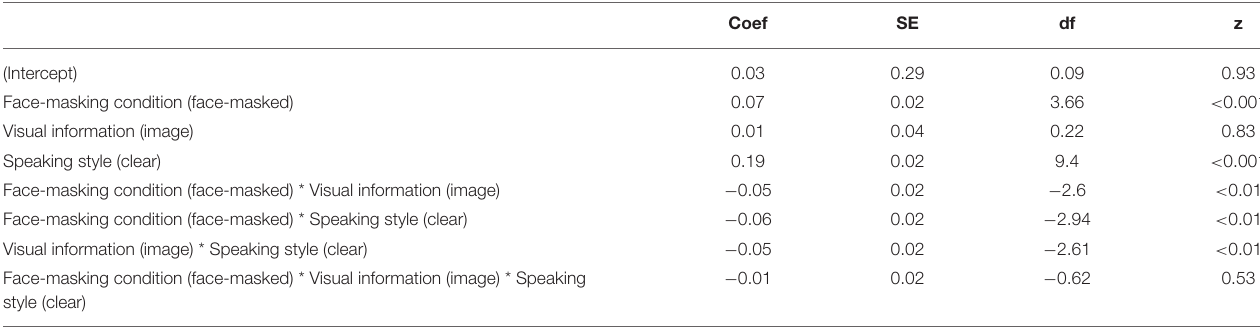
TABLE 2 | Summary statistics for the linear mixed effects model of Experiment 2, − 3 dB